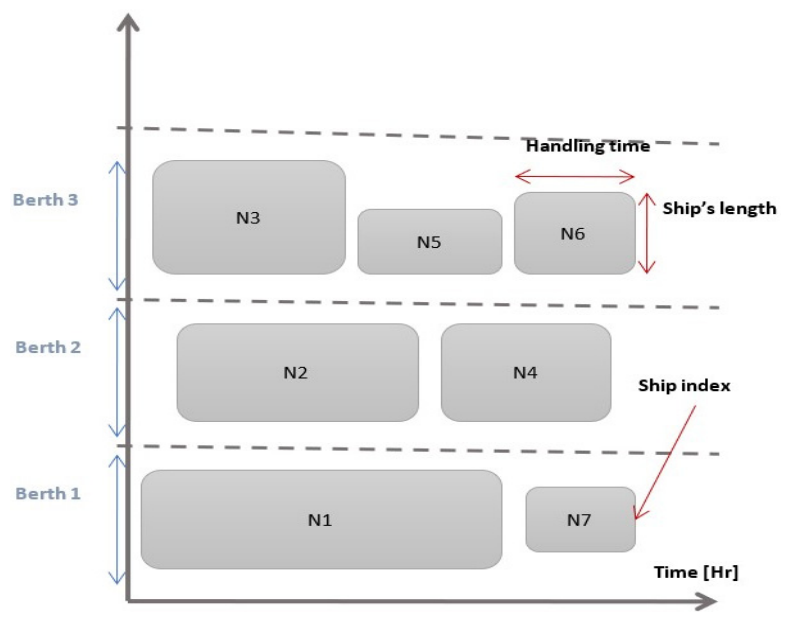
Figure 2. Spatiotemporal representation of a berthing operation with 7 vessels and 3 berths.